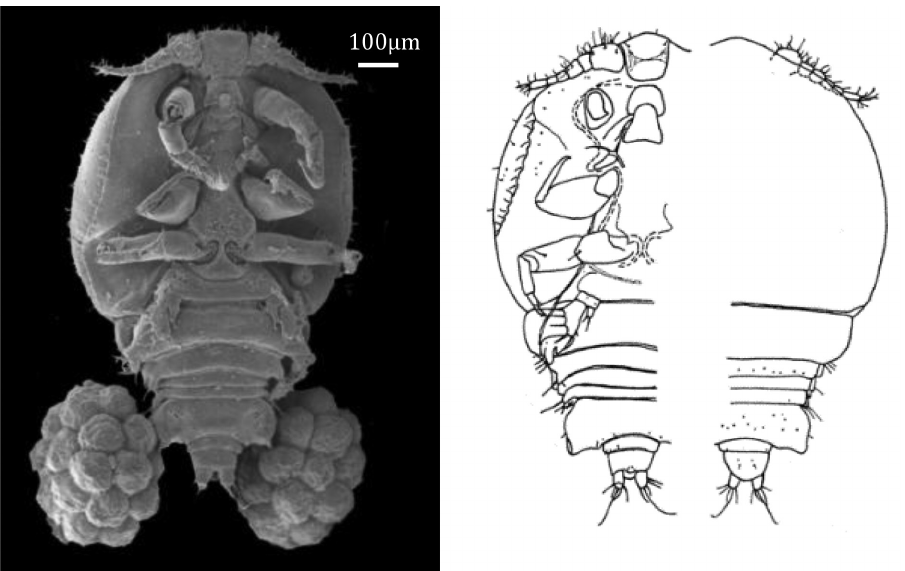
Figure 2. Left Scanned electron micrograph of ovigerous female Cancerilla oblonga from Amphiura capensis in Cape Town Right External features of Cancerilla oblonga from Luderitz, as drawn by Bartsch